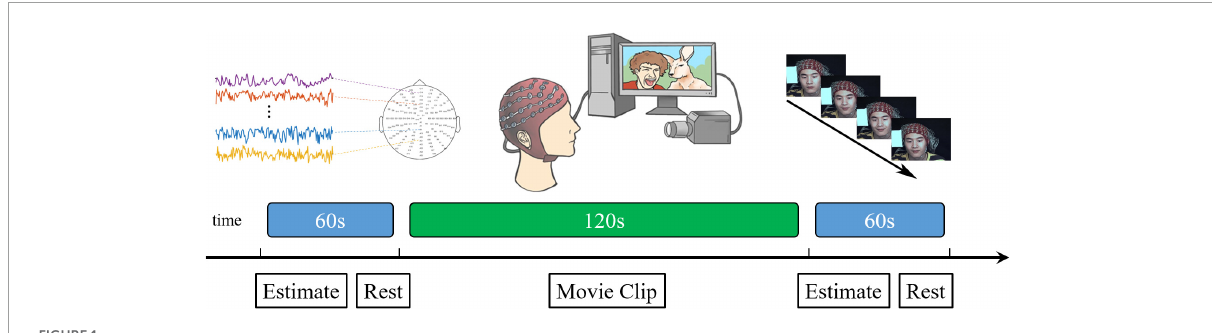
FIGURE1 Schematic representation of the presentation of a single block video